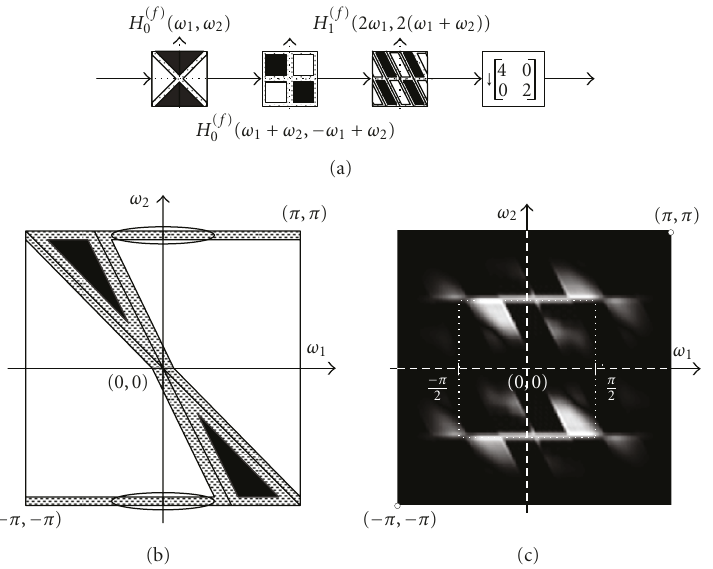
Figure 9: Aliasing e ff ect on DFBs obtained by using the tree structure: (a) the equivalent structure to obtain subband 0 in eight-band DFB structure in Figure 2, (b) the equivalent directional filter H 0 ( ω 1 , ω 2 ). Black, gray and white colors denote passband, transition band, and stopband, respectively, and (c) an example of the amplitude of frequency response of a contourlet basis at the second resolution level, displayed as a gray-scale image.